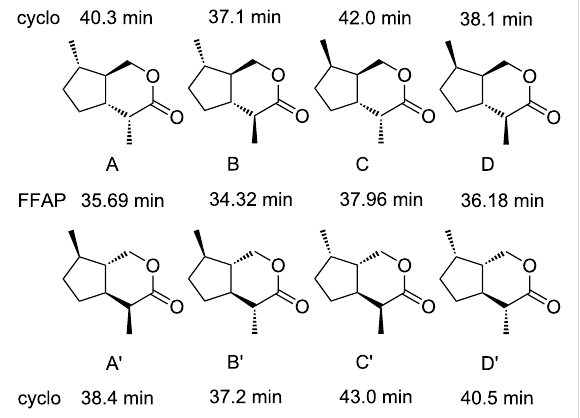
Figure 3: Chemical structures of all eight stereoisomers of trans -fused iridomyrmecins and their gas chromatographic retention times (min) on FFAP and on a cyclodextrin column (cyclo). For experimental details see Supporting Information File